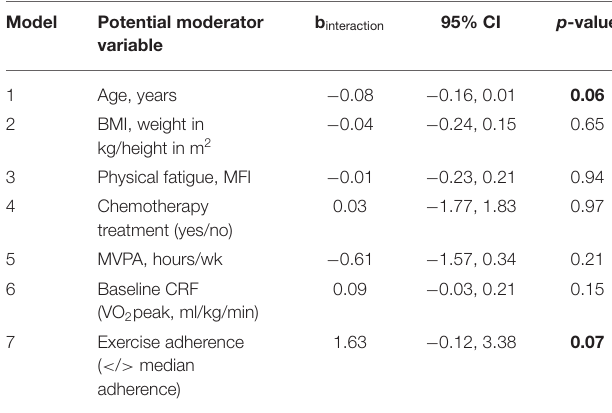
TABLE 1 | Baseline characteristics of participants with breast cancer in Phys-Can RCT. Data are presented as mean ( ± SD) or n (%). Characteristic